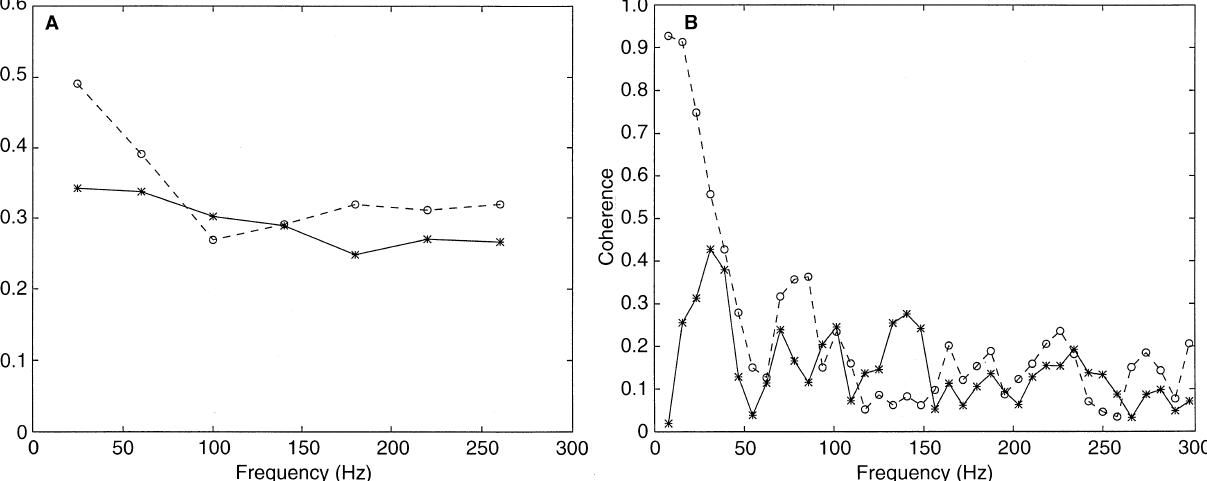
Fig. 12A, B. Cross-coherence of the waves as a function of frequency. The results in A are obtained by band-pass filtering the data, as when the results in Fig. 10 were obtained. In B we show the results obtained